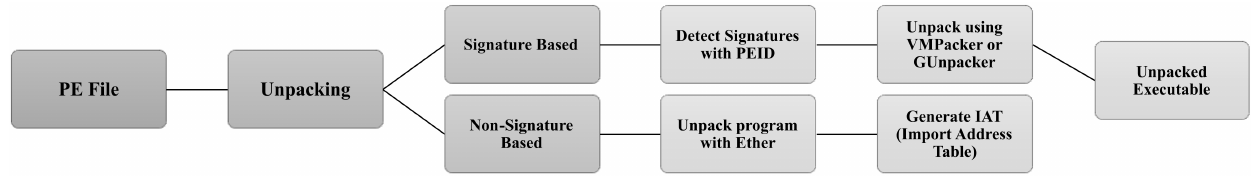
Figure 1. Software